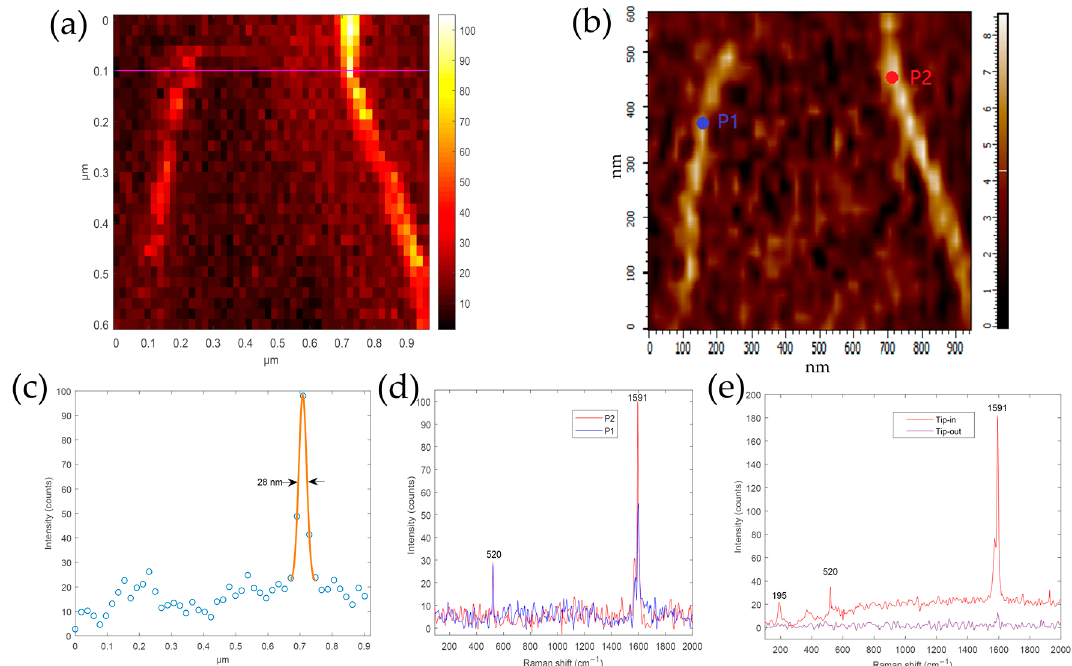
Figure 5. ( a ) TERS image and ( b ) AFM morphology of single-walled carbon nanotubes (SWCNTs) measured simultaneously. The TERS image of the SWCNTs was reconstructed from the G peak (1591 cm − 1 ). Exposure time of each pixel: 0.5 s, 50 × 30 pixels, laser power: 8 µ W. ( c ) Height profile taken along the purple line in ( a ), which indicates that the spatial resolution of the TERS experiment is about 28 nm. ( d ) TERS spectra of SWCNTs at two positions indicated in ( b ). ( e ) TERS spectrum and far-field spectrum of SWCNT using another TERS probe.